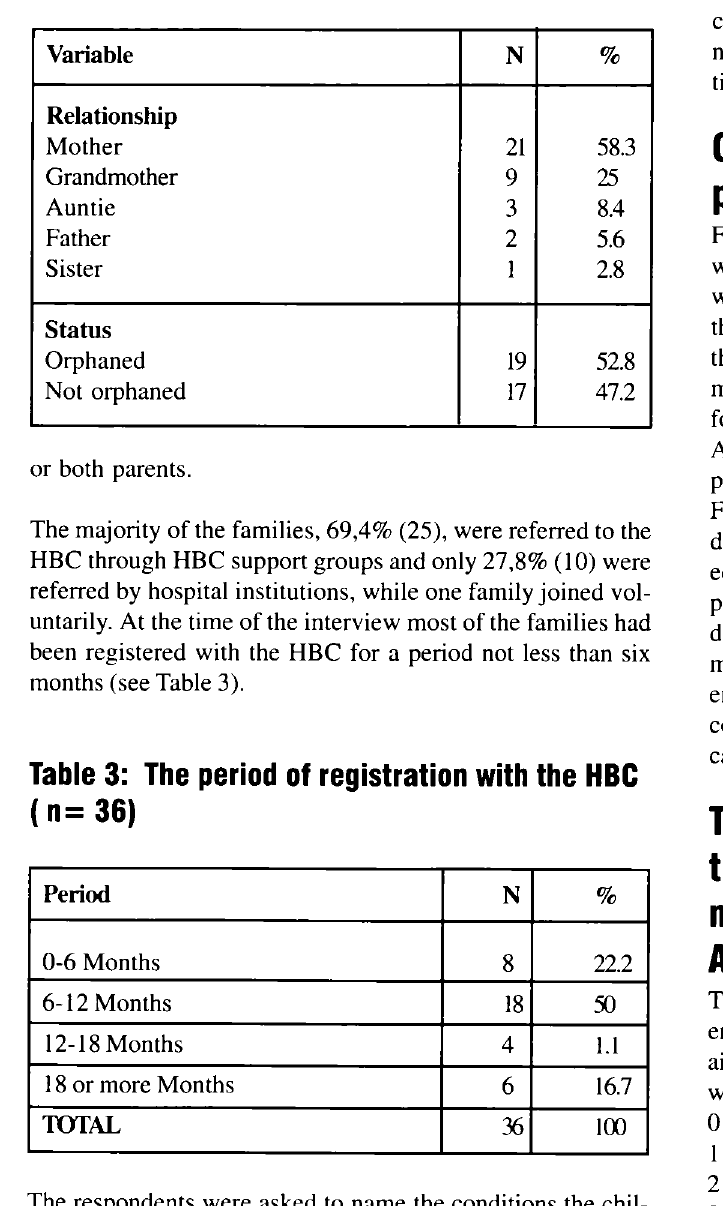
Table 2: Care giver’s relationship with the child and the parental status of the children (n=36 ).